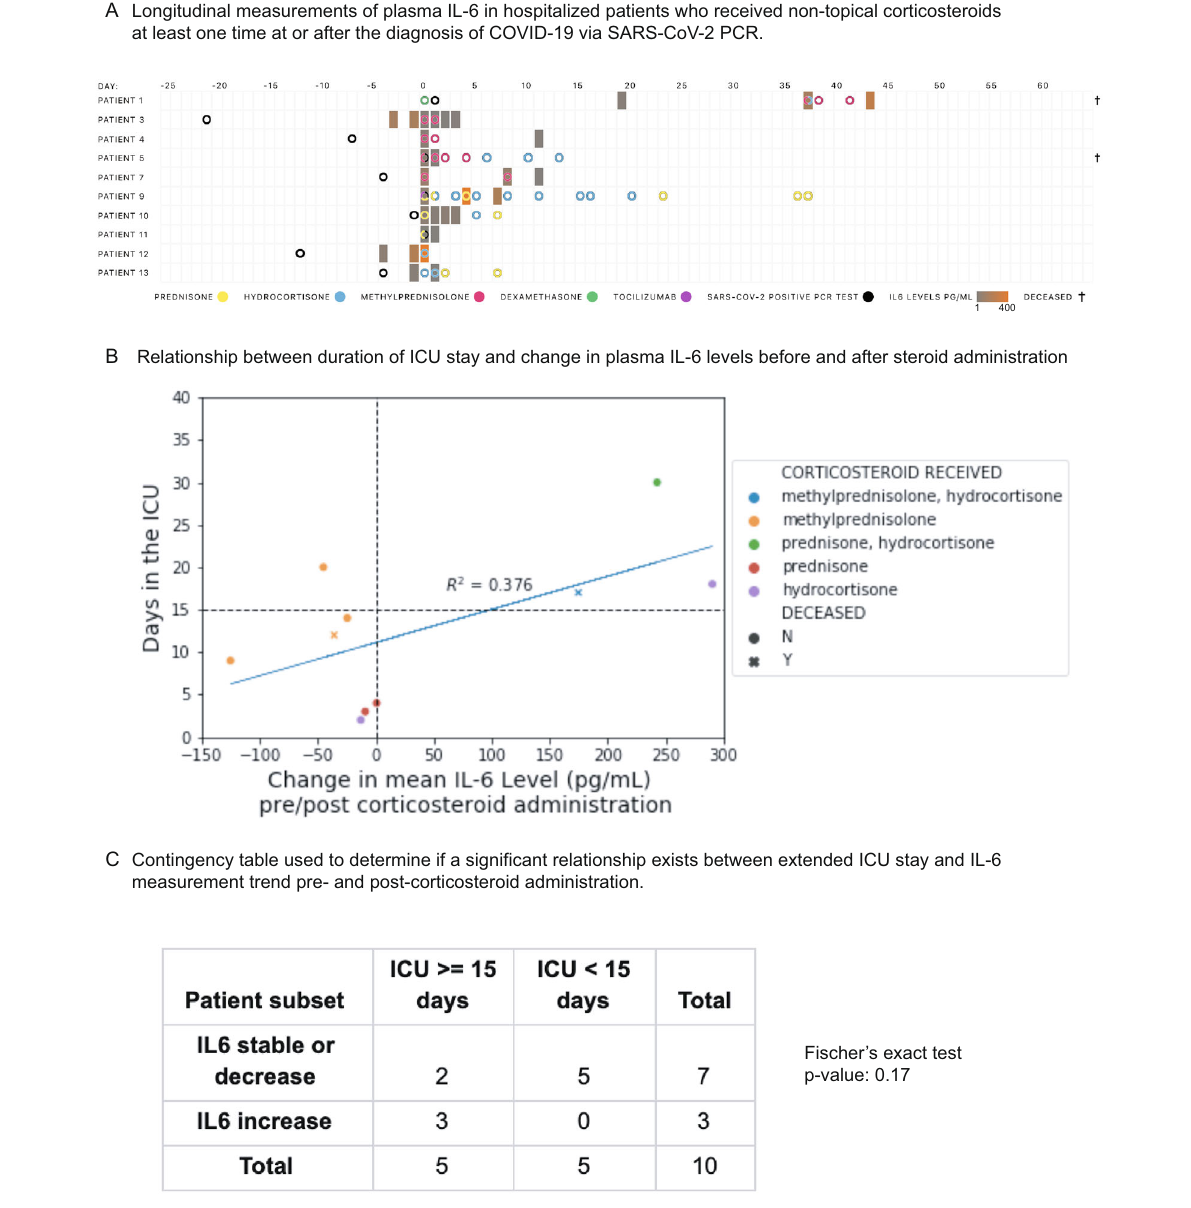
Fig. 2 Constraining cohort of COVID-19 ICU patients to those who had at least one plasma IL-6 measurement before and after corticosteroid administration. A Longitudinal measurements of plasma IL-6 in hospitalized patients who received non-topical corticosteroids at least one time at or after the diagnosis of COVID-19 via SARS-CoV-2 PCR. B Relationship between duration of ICU stay and change in plasma IL-6 levels before and after steroid administration (patient numbers are mapped onto Fig. 8a). If multiple pre/post-corticosteroid administration levels are available, the mean is used. C Contingency table used to determine if a signi fi cant relationship exists between extended ICU stay and IL-6 measurement trend pre- and post-corticosteroid